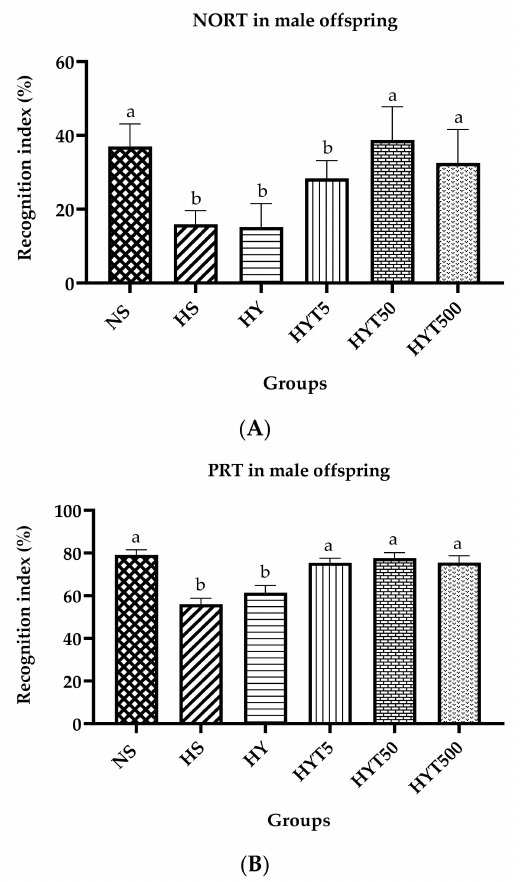
Figure 4. ( A ). Recognition index of male offspring in novel object recognition test (NORT). ( B ). Recognition index of male offspring in place recognition test (PRT). Different letters indicates a significant difference at p < 0.05.